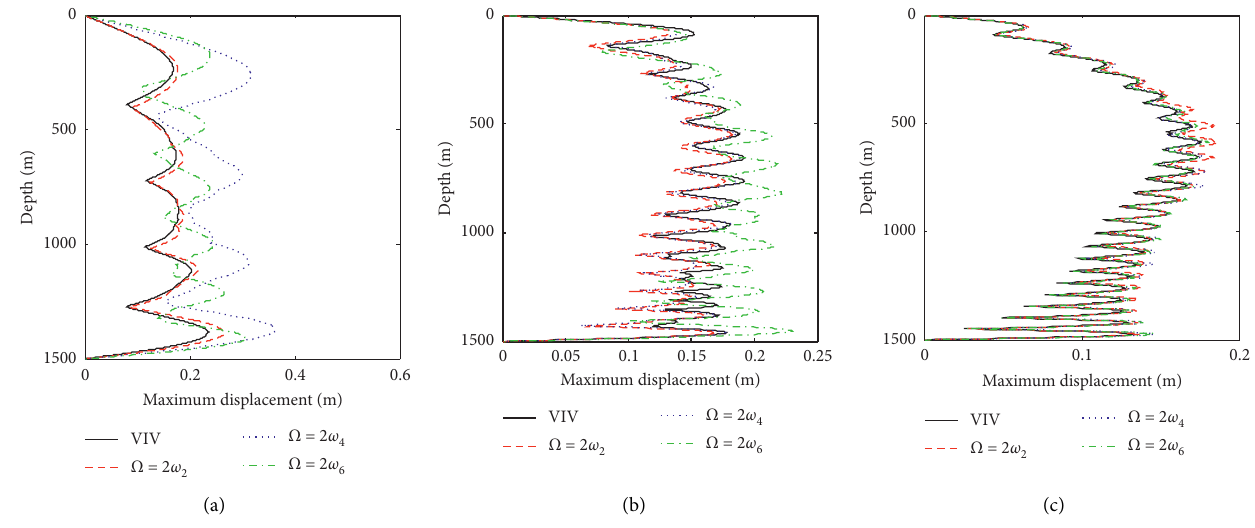
Figure 8: The maximum displacement of TTR ( a � 1 m ): (a) U